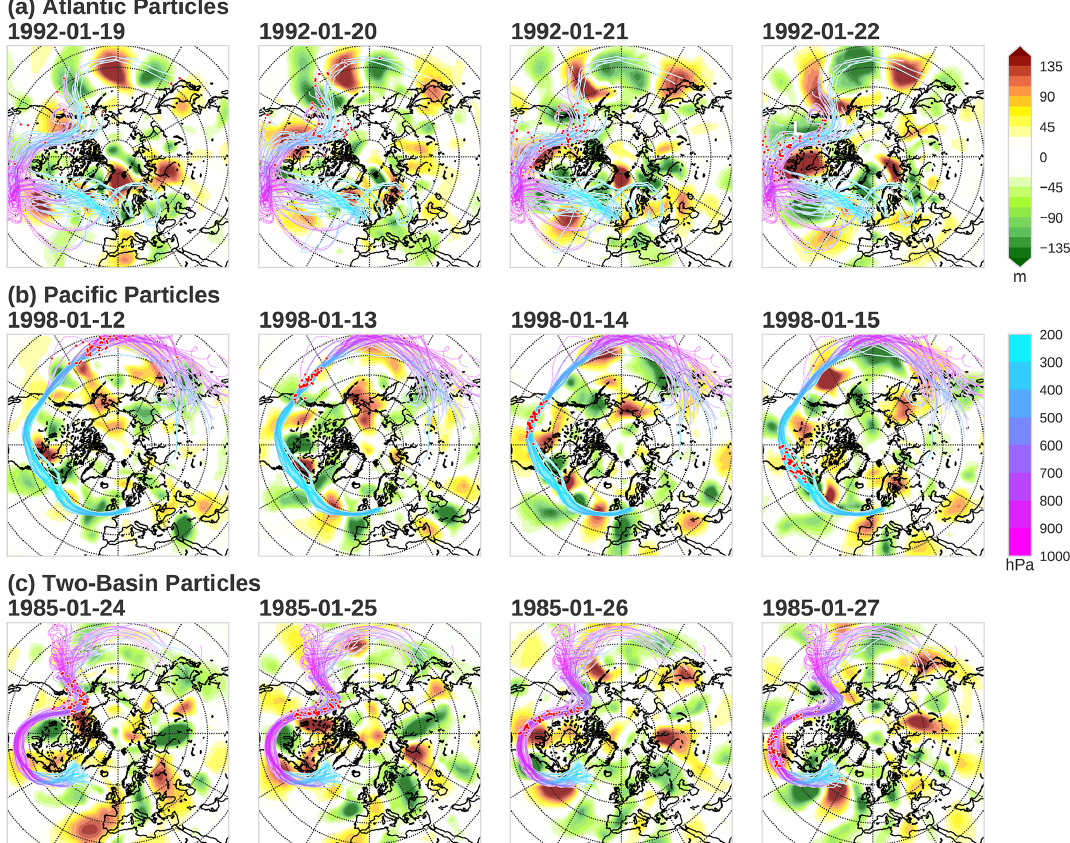
Figure 12. Case studies of particle locations (coloured lines) and associated synoptic-scale eddies (shaded as in the top right colour bar) for the Atlantic particles (a) , the Pacific particles (b) , and the two-basin particles (c) . The pressure levels [hPa] of up to 50 particles along their trajectories are plotted with coloured lines as indicated in the middle right colour bar. Their exact locations at the denoted times are indicated by red circles. The synoptic-scale eddies are defined as 8d high-pass-filtered geopotential height fluctuations at 350hPa. Parallels are plotted for every 10 ◦ , whereas meridians are plotted for every 30 ◦ on each